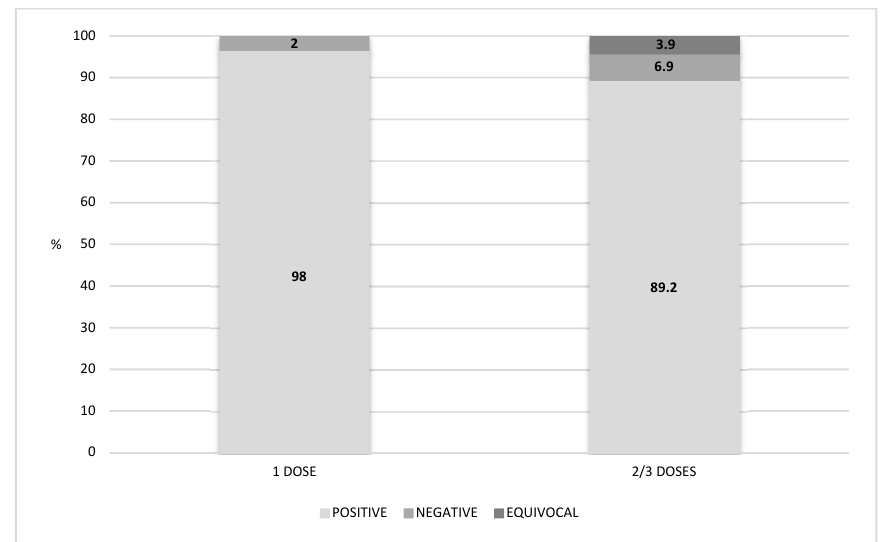
Figure 3. Percentage distribution of positive, negative and equivocal subjects according to the number of vaccine doses received.